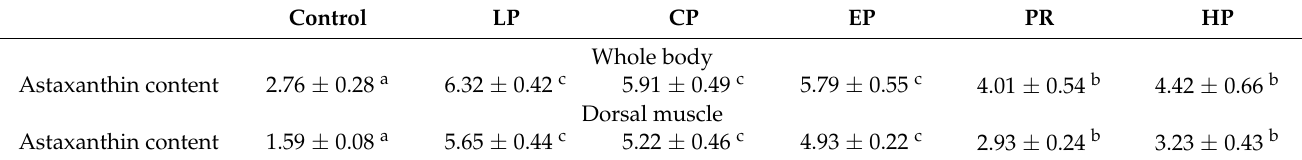
Table 4. Astaxanthin content (mg/kg) in the whole body and dorsal muscle of Oncorhynchus mykiss fed with the experimental diets.